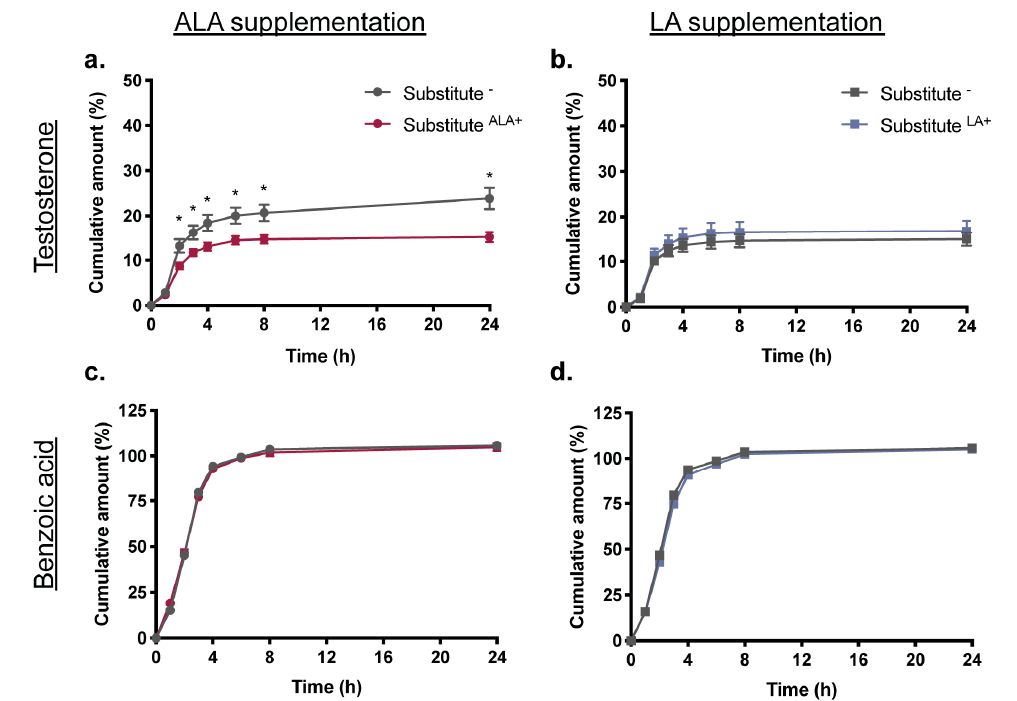
Figure 2. Skin substitute permeability to testosterone and benzoic acid. Influence of ( a , c ) ALA and ( b , d ) LA supplementation on the cumulative dose of ( a , b ) testosterone and ( c , d ) benzoic acid absorbed through the skin substitutes. Percutaneous absorption studies were performed on a Franz cells di ff usion system. The dosing solutions were freshly prepared in ethanol / water (1:1), yielding a concentration of 4.0 mg / mL for each compound. Compounds were quantified with a Waters Acquity UPLC. Values are mean +/ − standard error of the mean (SEM) (3 donors, 6 skin substitutes per donor), p -values were derived from Student’s t -tests. * p < 0.05. Table 1. Mean maximum fluxes of testosterone (2 h) and benzoic acid (3 h) through the skin substitutes. Molecules